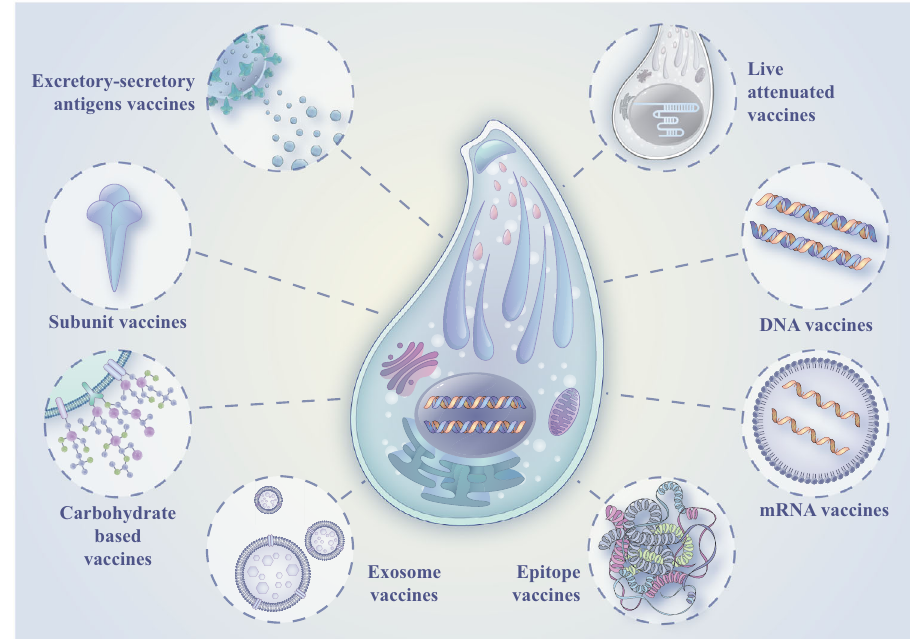
Fig. 1 Anti- T. gondii